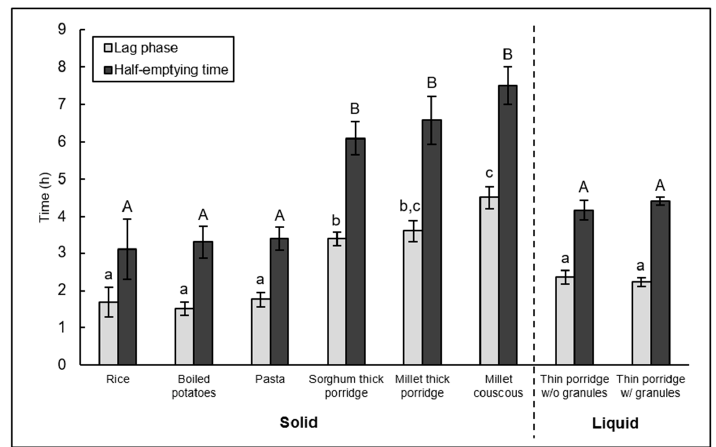
Figure 1. Gastric emptying parameters from the main study uncorrected for background differences in 13 C content of food sources. Mean values (error bars (SEM), n = 14) of lag phase and half-emptying time of the different solid and liquid test meals. Means not sharing the same letter are significantly different ( p < 0.05, statistical analysis was done separately for solid and liquid test meals). w/o = without, w/ = with. Table 5. Gastric half-emptying and lag phase times (main study ( n = 14); validation study ( n =